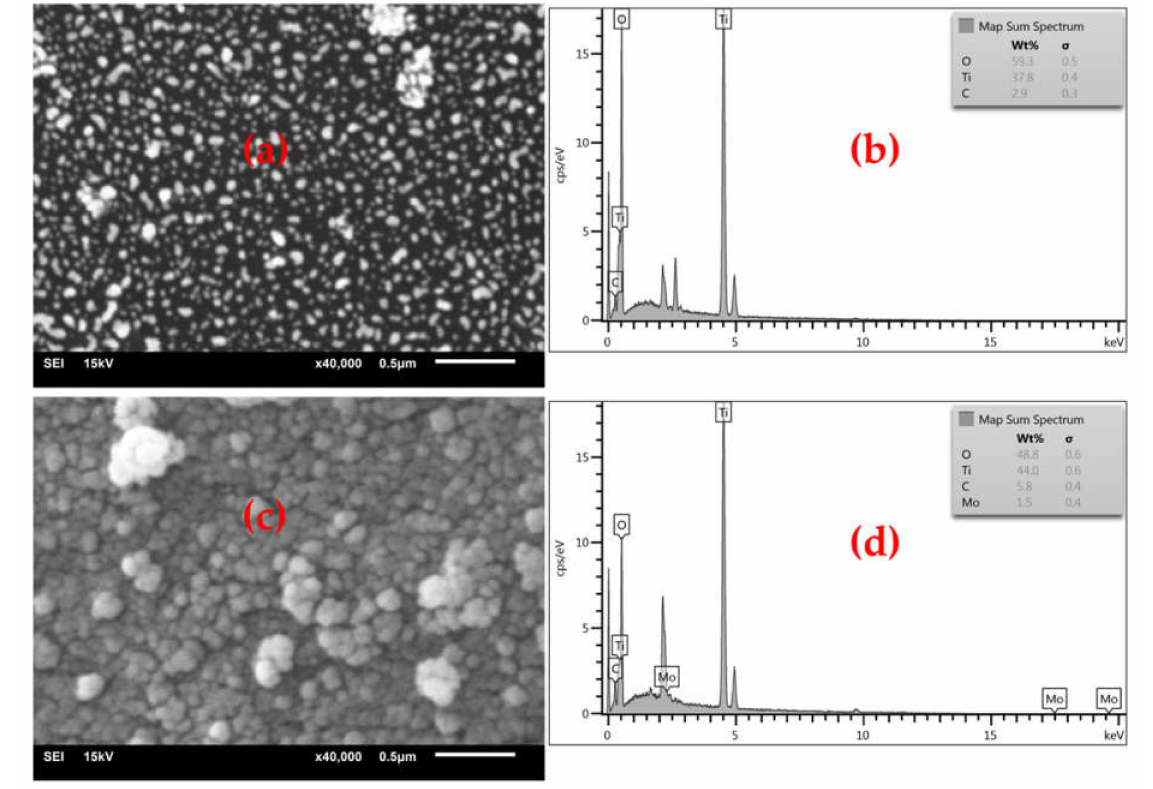
Figure 4. SEM measurement images of ( a ) unmodified SynTiO 2 , and ( c ) modified Mo/SynTiO 2 , and their corresponding EDS maps for ( b ) unmodified SynTiO 2 and ( d ) modified Mo/SynTiO 2 .